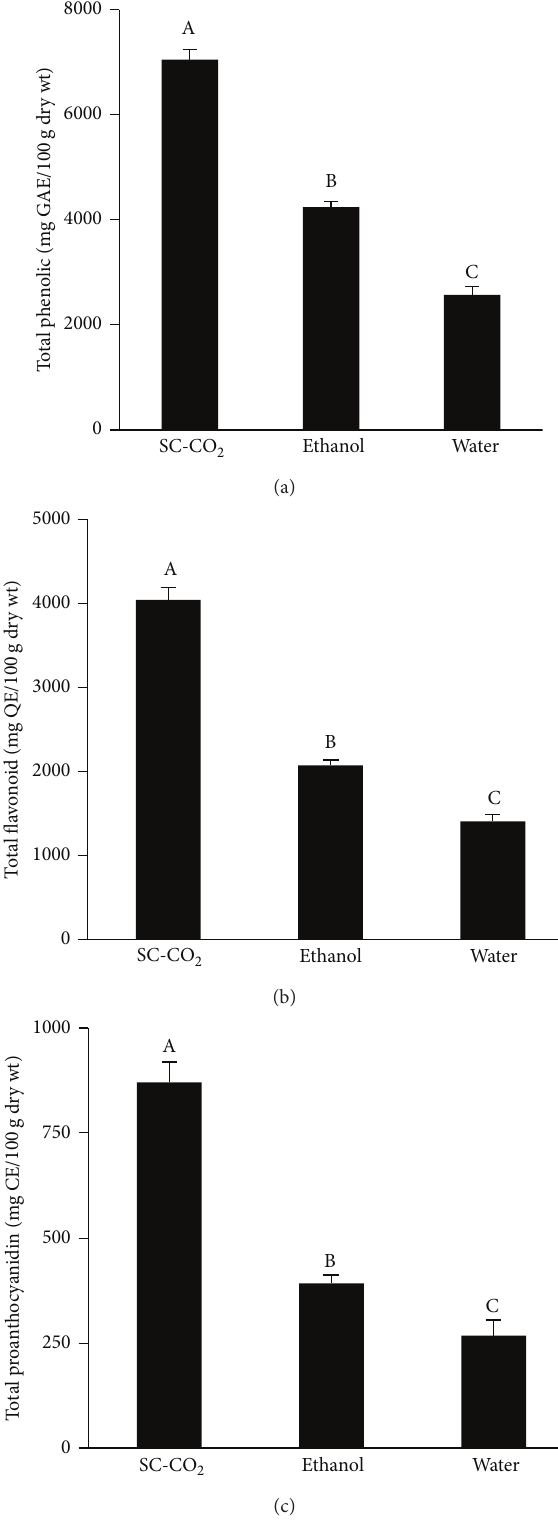
Figure 1: Effects of SC-CO 2 extraction of Antidesma thwaitesianum on (a) total phenolic, (b) total flavonoid, and (c) total proantho- cyanidin contents. Values are mean ± SD ( 𝑛 = 3 ). GAE, gallic acid equivalent; QE, quercetin equivalent; CE, catechin equivalent. Means with different letters (A–C) are significantly different ( 𝑃 < 0.05